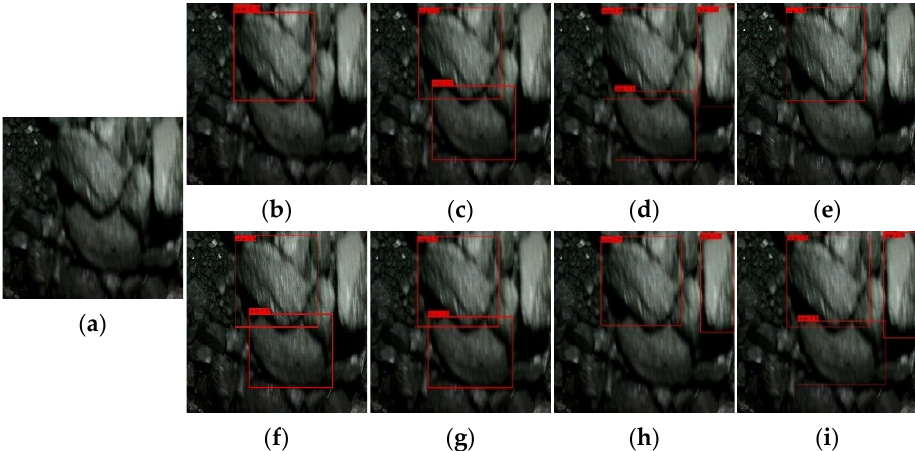
Figure 12. Results of big coal block detection via different networks—the fourth image. ( a ) origin;